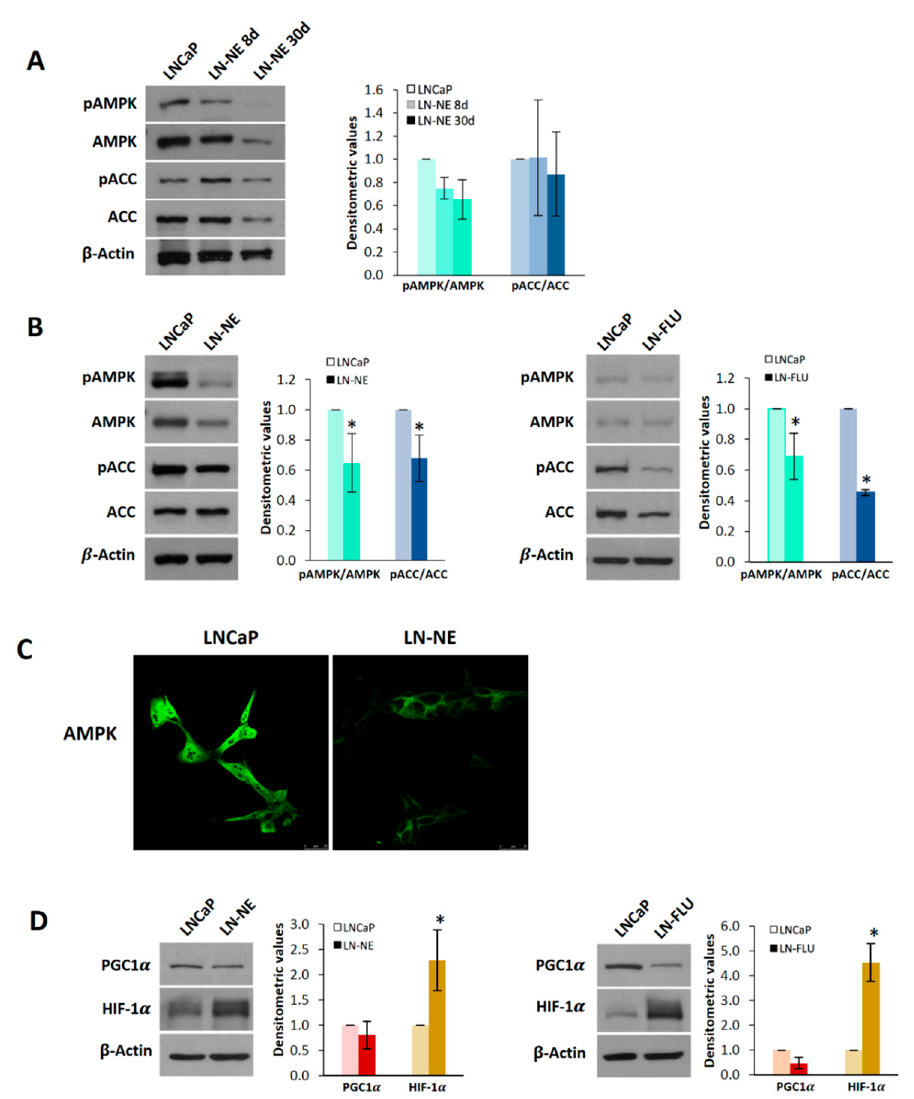
Figure 4. AMP-activated kinase (AMPK) is down-regulated in prostate stem-like cells. ( A ) Levels of phosphorylated AMPK (pAMPK), total AMPK, phosphorylated ACC (pACC), and total ACC were determined in LN-NE cells at 8 and 30 days by Western blot. Image is representative of three di ff erent experiments. Densitometric values are shown on the right. ( B ) Levels of pAMPK, AMPK, pACC, and ACC in LN-NE cells at 90 days of androgen withdrawal and in LN-FLU cells at two months. Image is representative of four di ff erent experiments. Densitometric values are shown on the right of each image. ( C ) Confocal images showing AMPK immunostaining in LN-NE cells at 90 days. ( D ) Levels of the transcriptional coactivator PGC-1 α and the hypoxia-inducible factor HIF-1 α in LN-NE and LN-FLU cells determined by Western blot. Image is representative of three di ff erent experiments. Densitometric values are shown on the right of each image. * p < 0.001 significant di ff erence between LNCaP and LN-NE cells or LNCaP and LN-FLU cells by two-way ANOVA and Sidak’s multiple comparisons test.